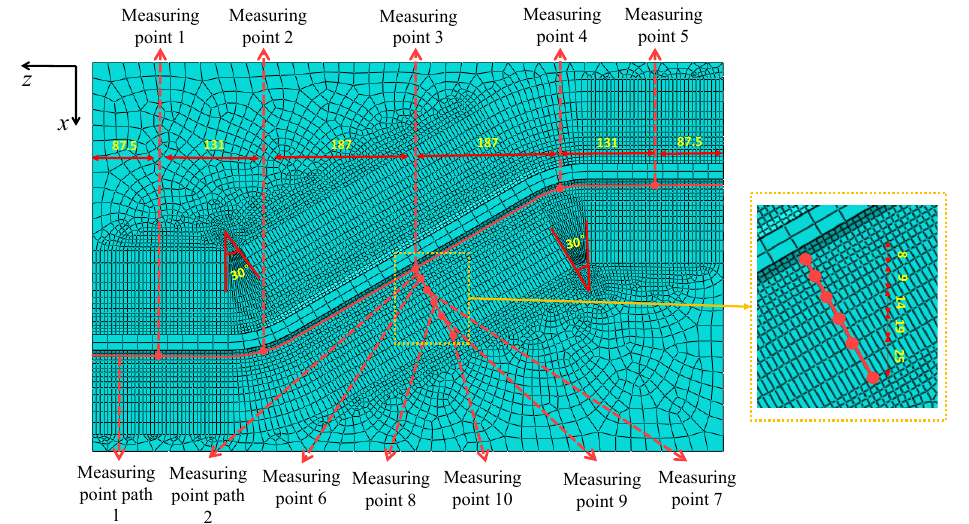
Figure 12. Layout diagram of temperature measuring points for weldments.